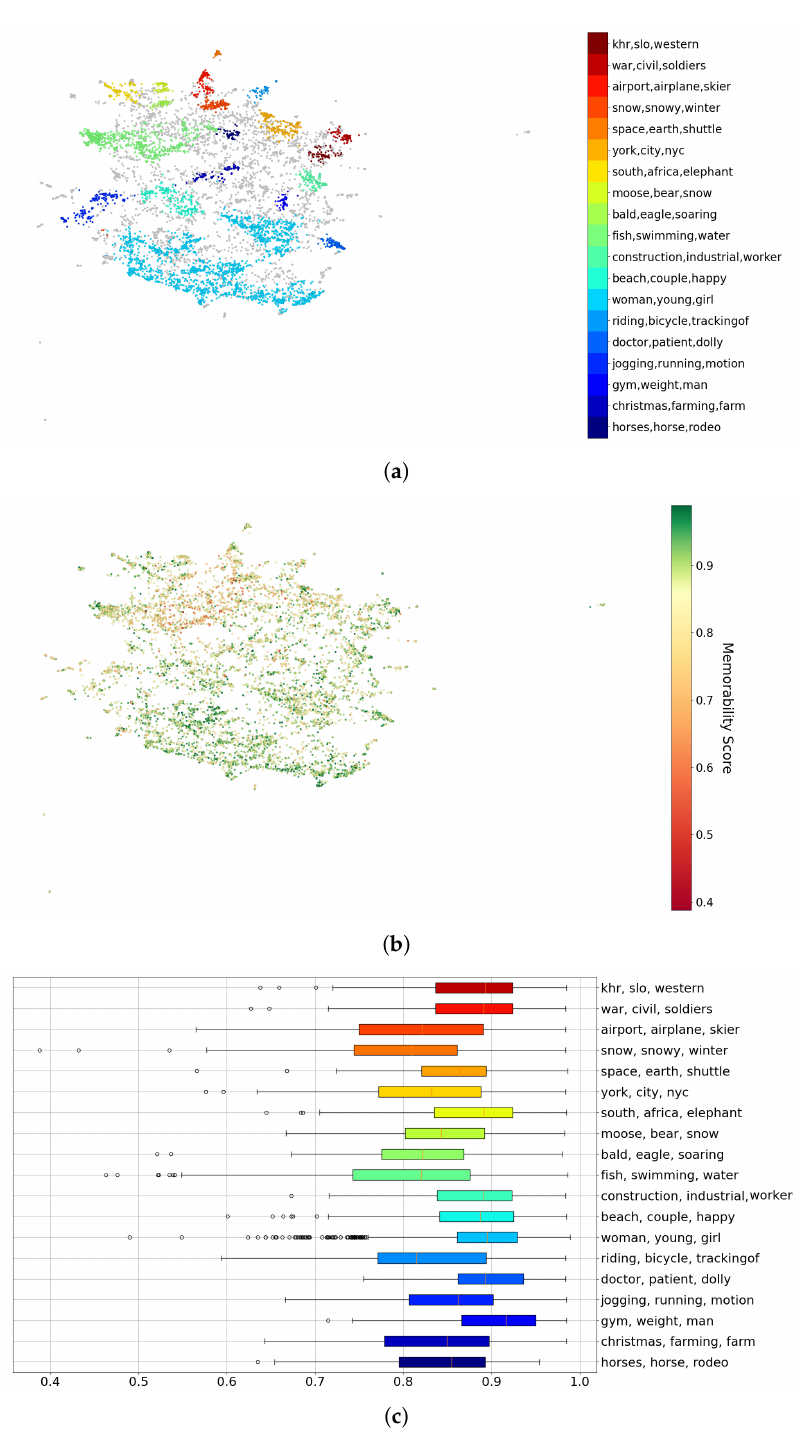
Figure 3. Automatic topic discovery from Sentence-BERT vector embeddings in the short-term memorability problem. From an unsupervised point of view, there seems to be some topics that tend to produce stronger memories. In particular, those related to people. ( a ) VideoMem’s topics. Each one is defined by each cluster’s top 3 most representative words. Gray samples cannot be assigned to any topic. ( b ) Samples shown in color according to their memorability score. Low memorability regions can be spotted. ( c ) Distribution of memorability scores within each detected